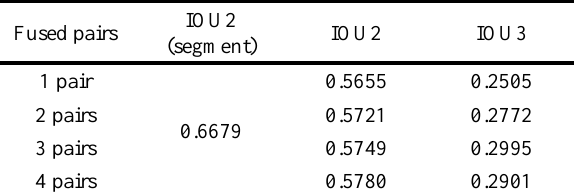
Table. 3. Accuracy evaluation of different DSM